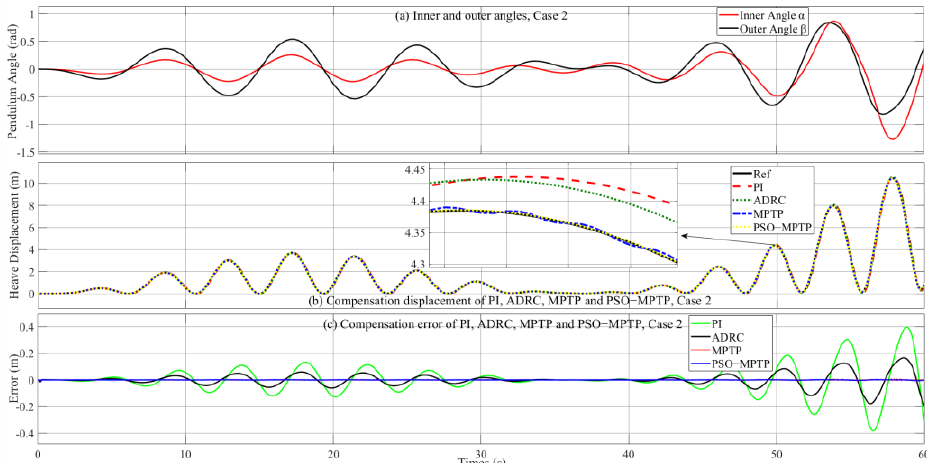
Figure 10. ( a ) Inner and outer angles, Case 2. ( b ) Compensation displacement of PI, ADRC, MPTP, and PSO − MPTP, Case 2. ( c ) Compensation error of PI, ADRC, MPTP, and PSO − MPTP, Case 2. Case 3: L = 25 m and V = − 0.2 m/s